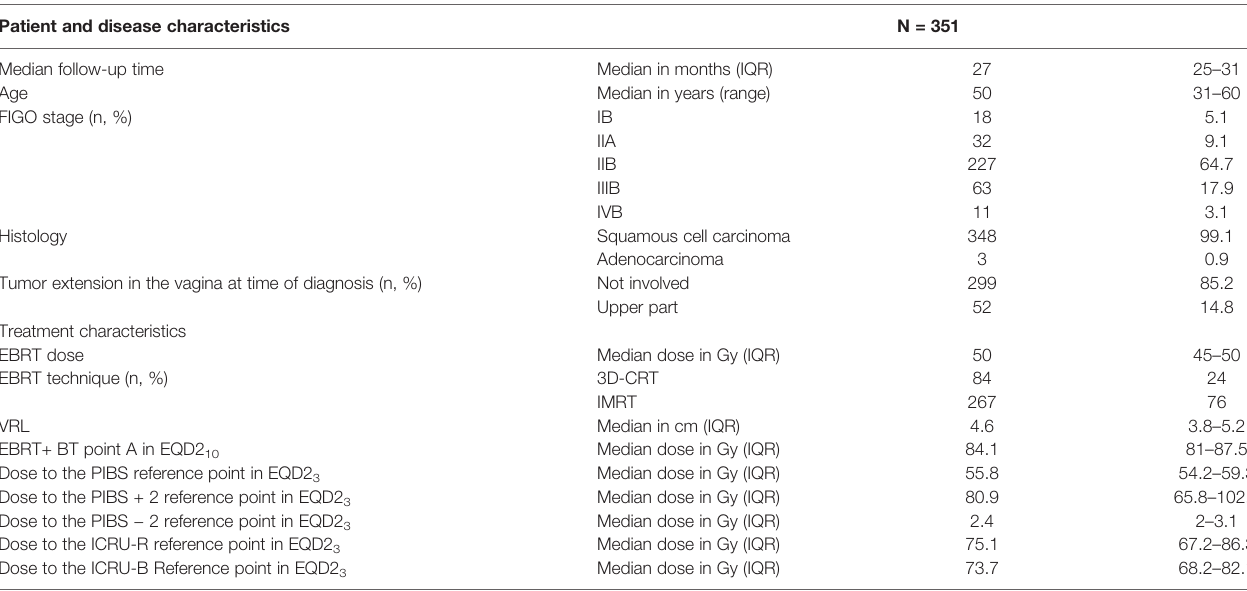
TABLE 1 | Patient, disease, and treatment characteristics.